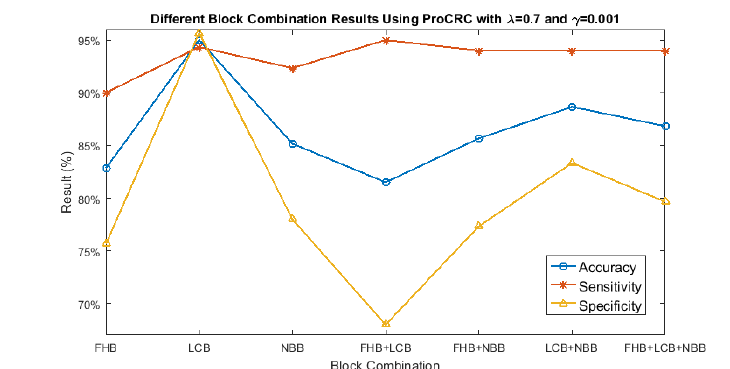
Figure 10. Different block combination results of Brain Disease (BD) vs. Healthy (H).